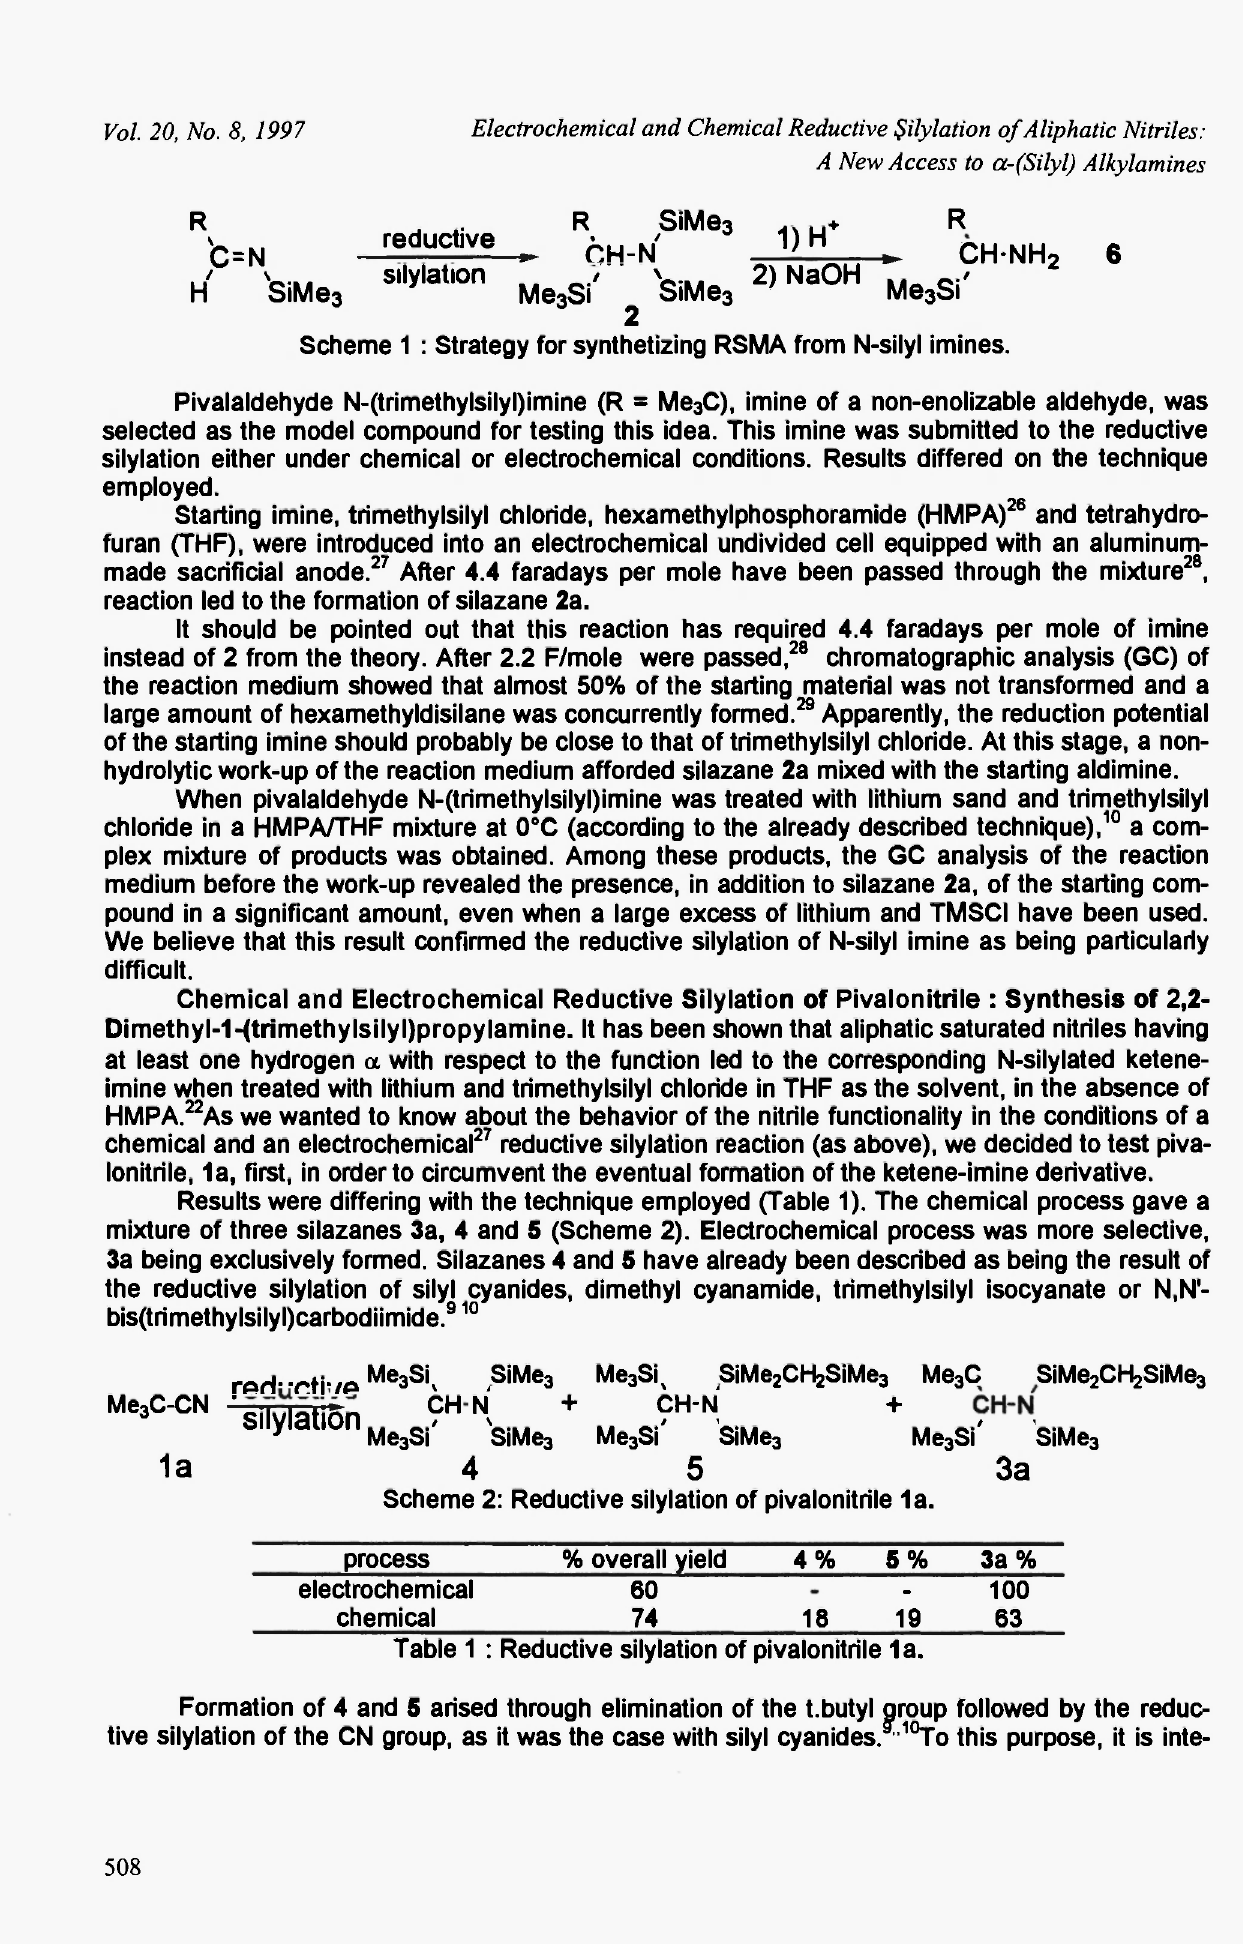
Scheme 2: Reductive silylation of pivalonitrile 1a.